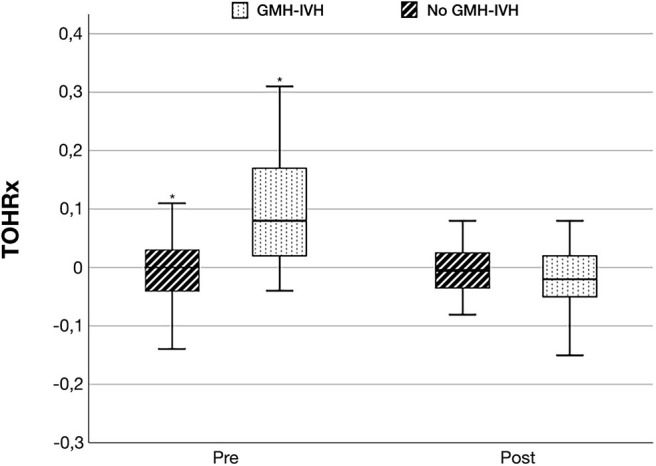
Tissue oxygenation-heart rate reactivity index (TOHRx) before and after GMH-IVH detection in infants who developed GMH-IVH and during matched time periods in the control group. *p < 0.001.